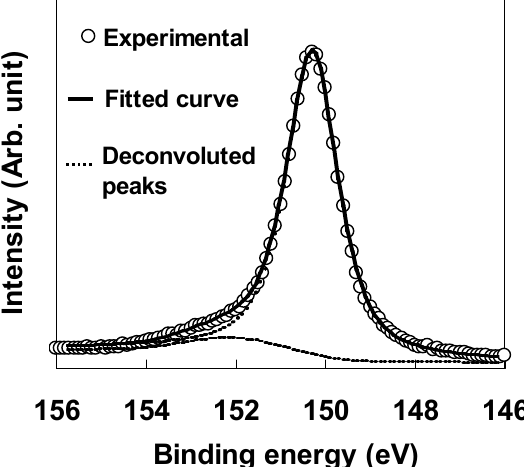
/Si structure and the curve fitting 3